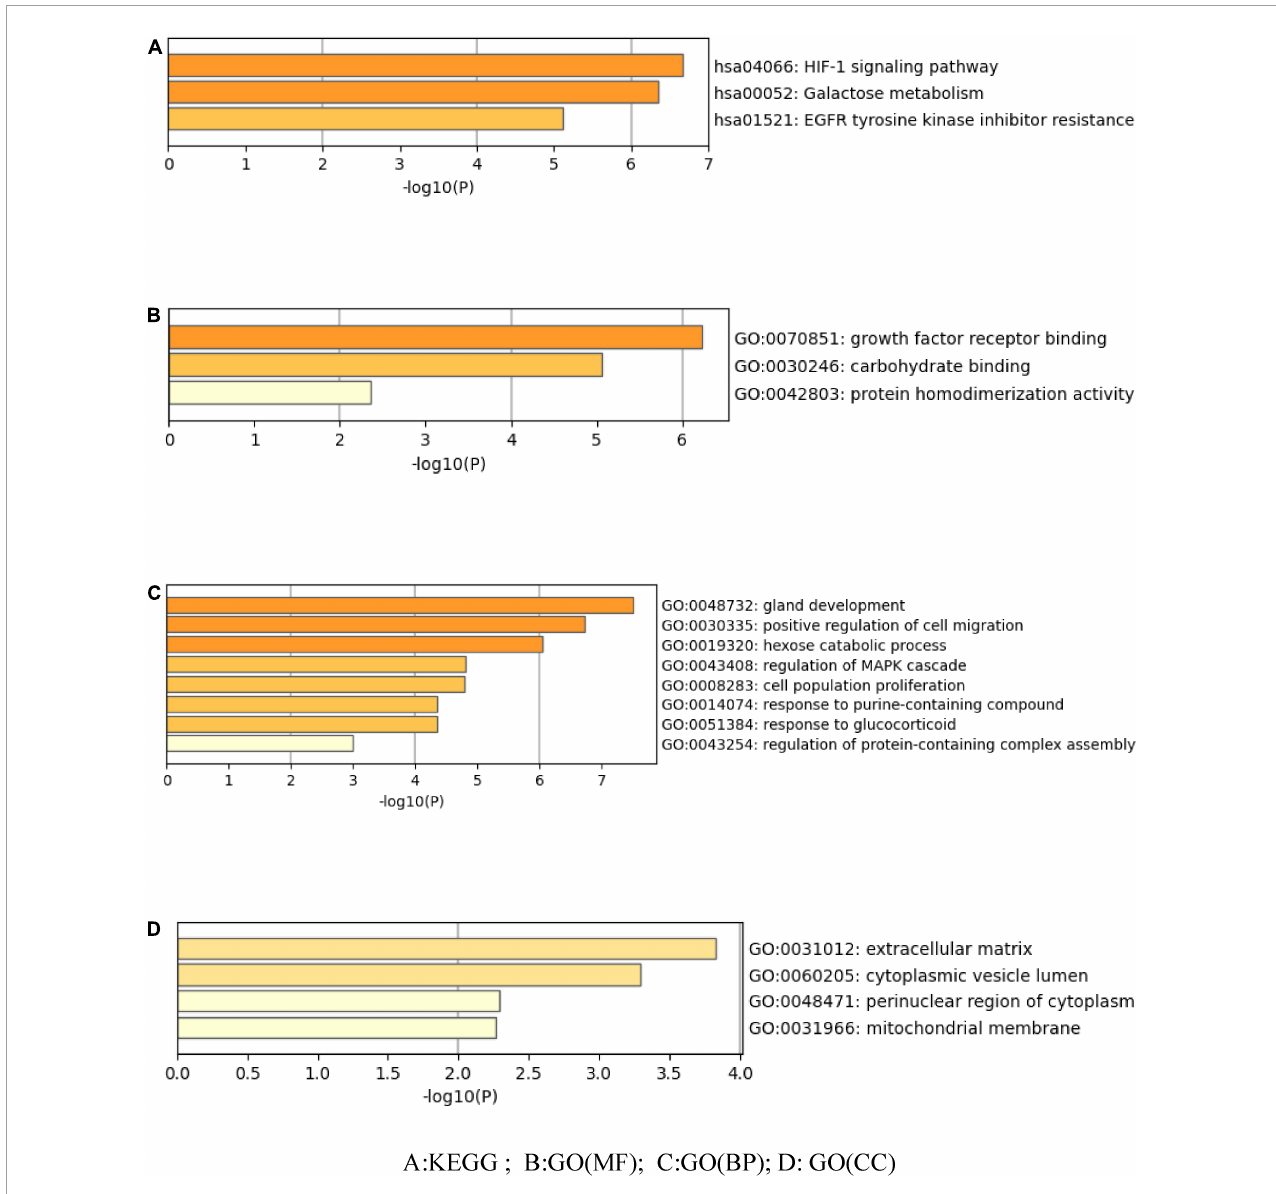
FIGURE4 Enrichment analysis of potential targets of seabuckthorn polysaccharides. (A) KEGG; (B) GO (MF); (C) GO (BP); (D) GO